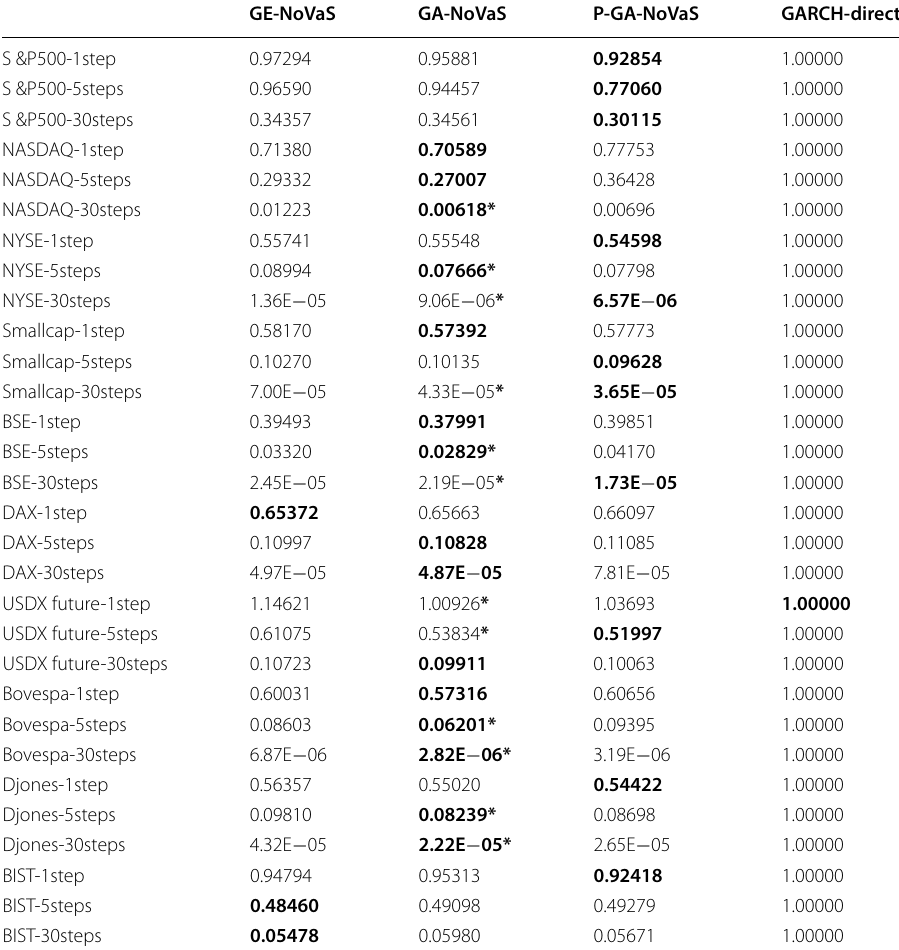
Table 7 Comparison results of using volatile 1-year index